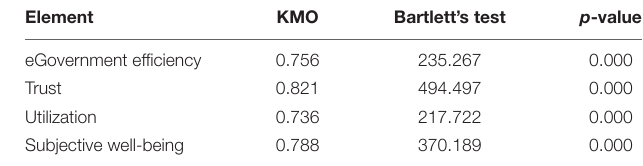
TABLE 2 | Results of the validity